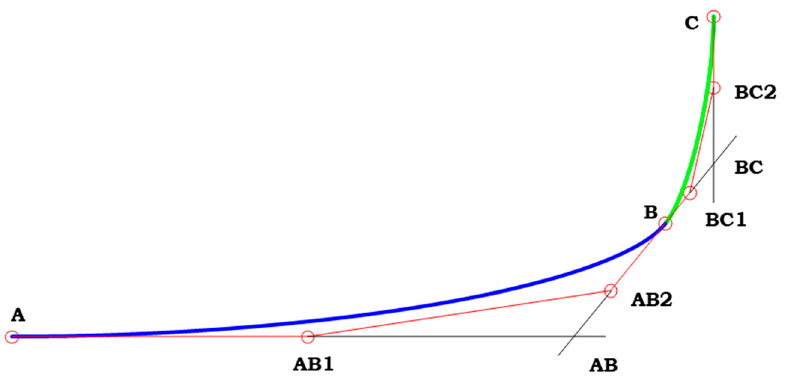
Figure 10. Section modeled with a G2 third-degree rational Bézier curve.